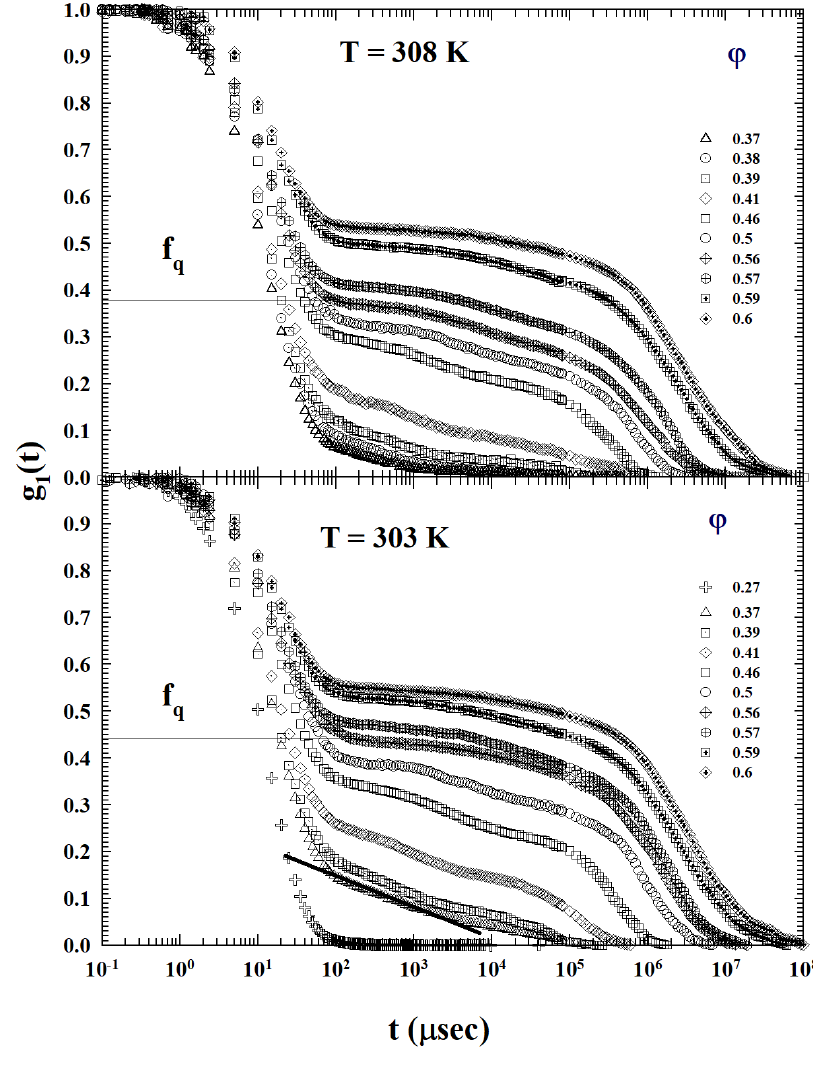
Figure 1. The dendrimer methanol ISFs measured in the range 0.27 < ϕ < 0.6 for T = 308 and 303 K. For T = 308 K ( top ) the behavior are analogous to that at T = 313 K (figure in Section 3.2): none of the illustrated ISFs show the AHS logarithmic decay. Whereas, for 303 K ( bottom ), such a decay is observable only for ϕ = 0.37. In both cases, the critical ( ϕ c ) appears to be greater than ϕ =